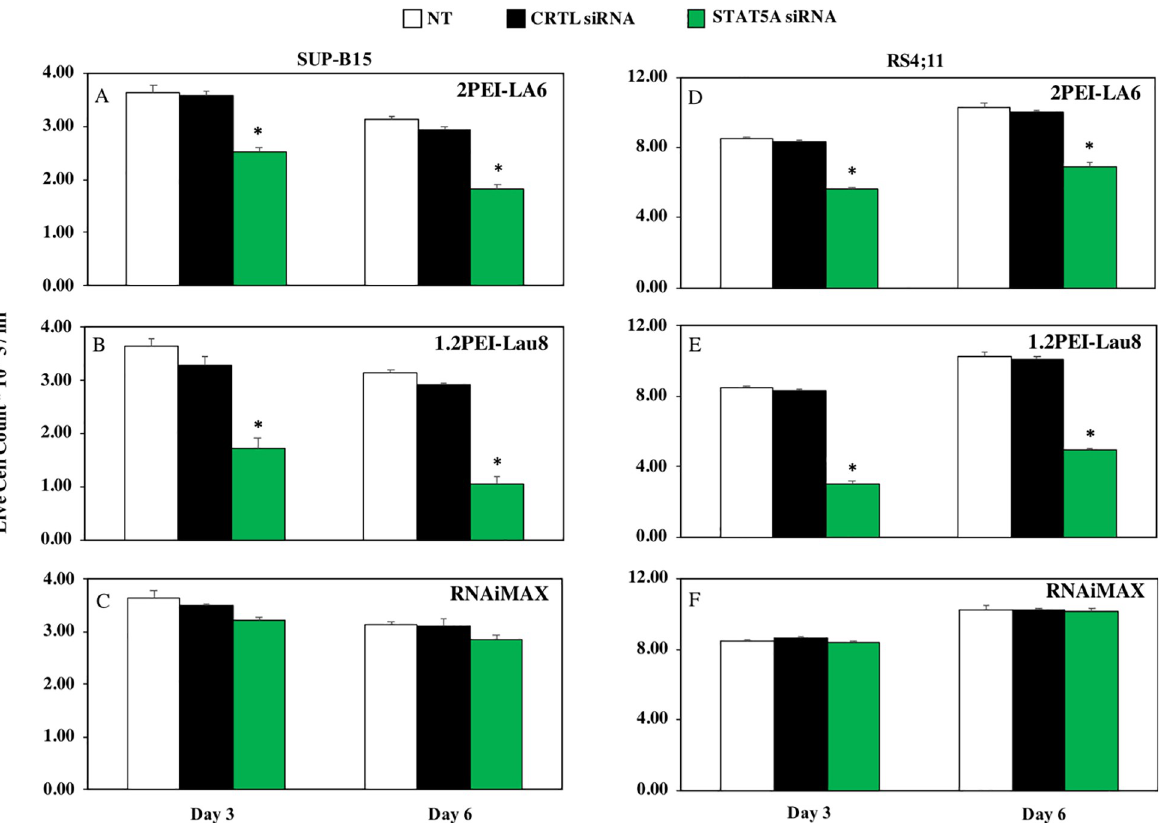
Fig 3. The growth inhibition of cells by complexes. Cells were transfected with CTRL/STAT5A siRNA complexes and live cells were counted by trypan blue exclusion assay after 3 and 6 days of treatment. Y-axis indicates the live cell count (x 10^5) per ml. Live cell counts in SUP-B15 and RS4;11 cells using 2PEI-LA6 (A and D), 1.2PEI-Lau 8 (B and E) polymers along with RNAiMAX (C and F) are indicated at two time points and values are shown as means ± SD; (n = 3) � p � 0.05 versus control